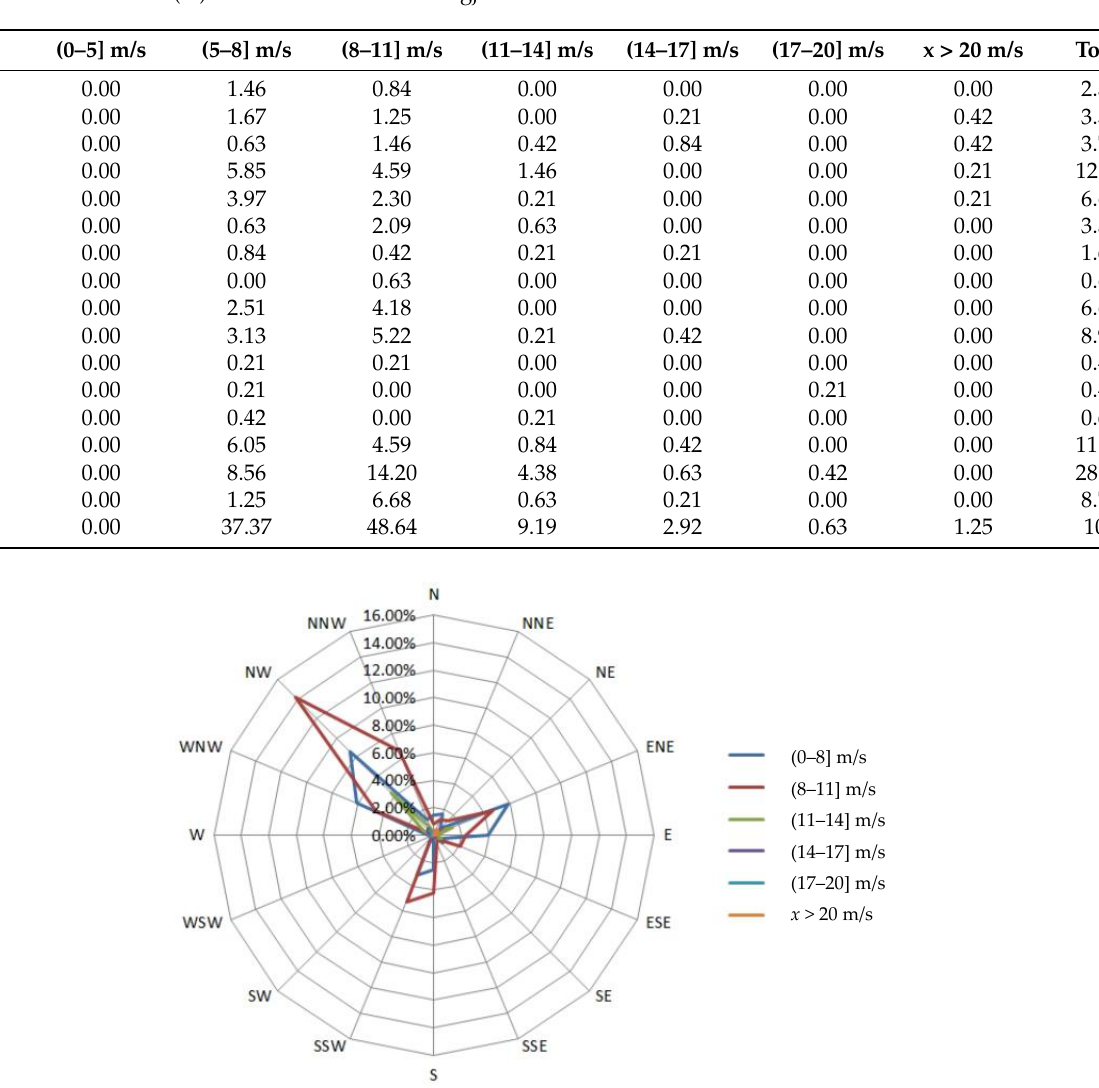
Table 3. Occurrence frequency of monthly extreme wind samples in each direction and speed range (%) from 1978 to 2021 at Hongjia station.